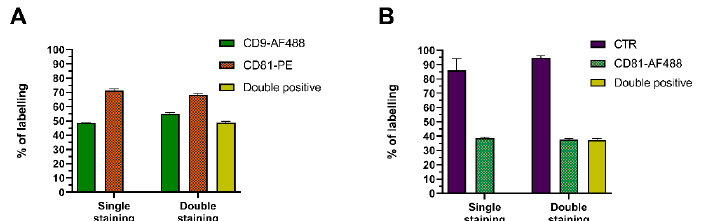
Figure 6. Multiplex fluorescence analysis for enhanced sEV identification and characterization. ( A ) Purified HT29 sEVs were labeled with anti-CD9-AF488 and anti-CD81-PE either individually (single staining) or in combination (double staining). ( B ) HT29 sEVs were stained with CTR and anti-CD81- AF488 either individually or in combination. Results are shown as % of labeled particles detected on nFCM, in two fluorescence channels ( n = 3; mean ±